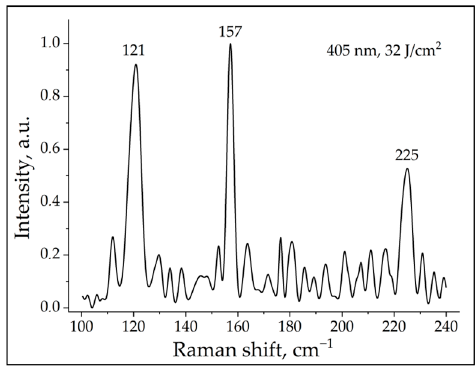
Figure 3. Raman spectrum of neutrophils exposed to radiation with a wavelength of 405 nm and a dose of 32 J/cm 2 . The characteristic la tt ice vibrational modes of citrulline can be seen.